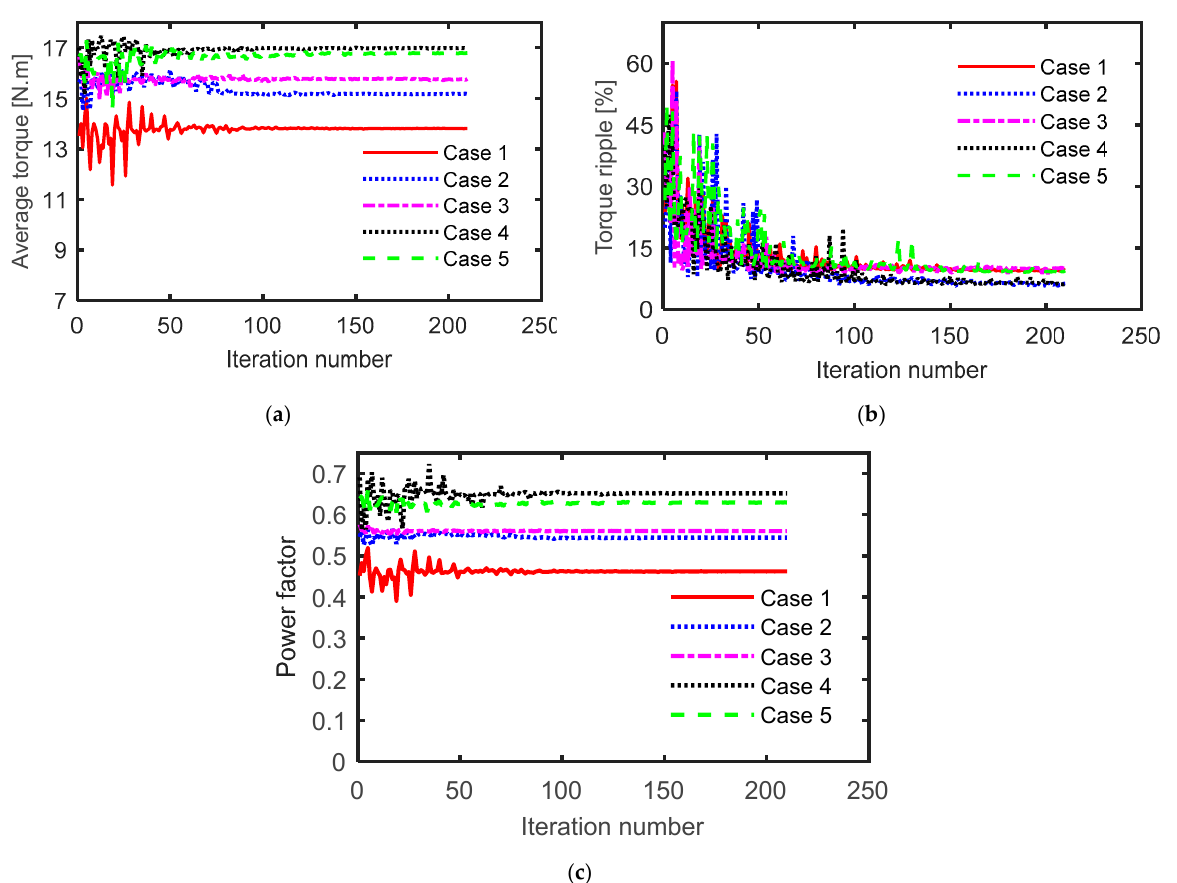
Figure 5. ( a ) Average torque, ( b ) torque ripple, and ( c ) power factor versus iteration number for different cases.